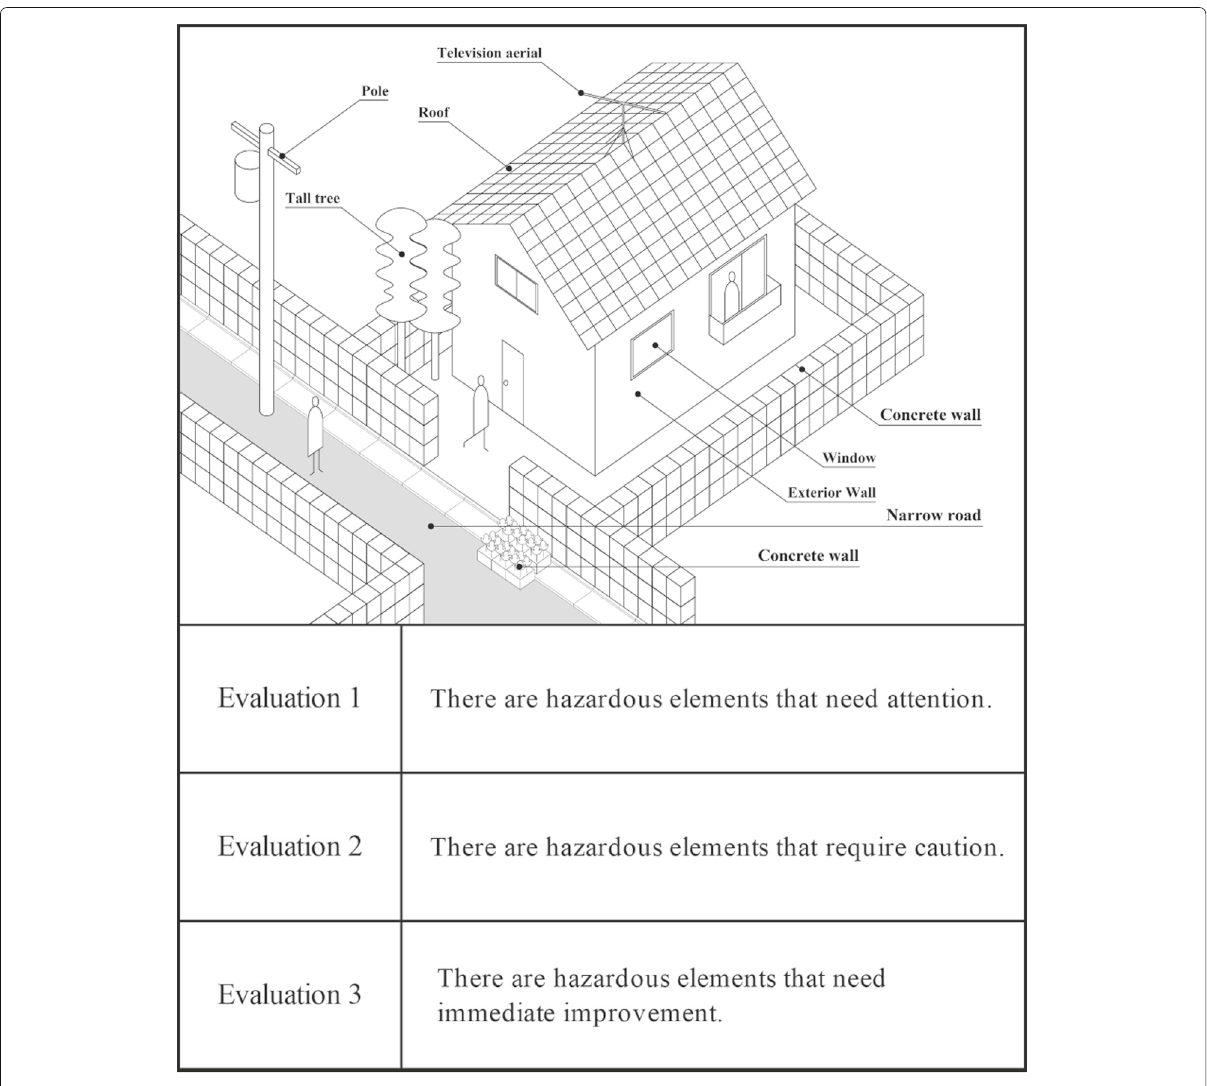
Fig. 2 Location of hazardous elements and their evaluation criteria